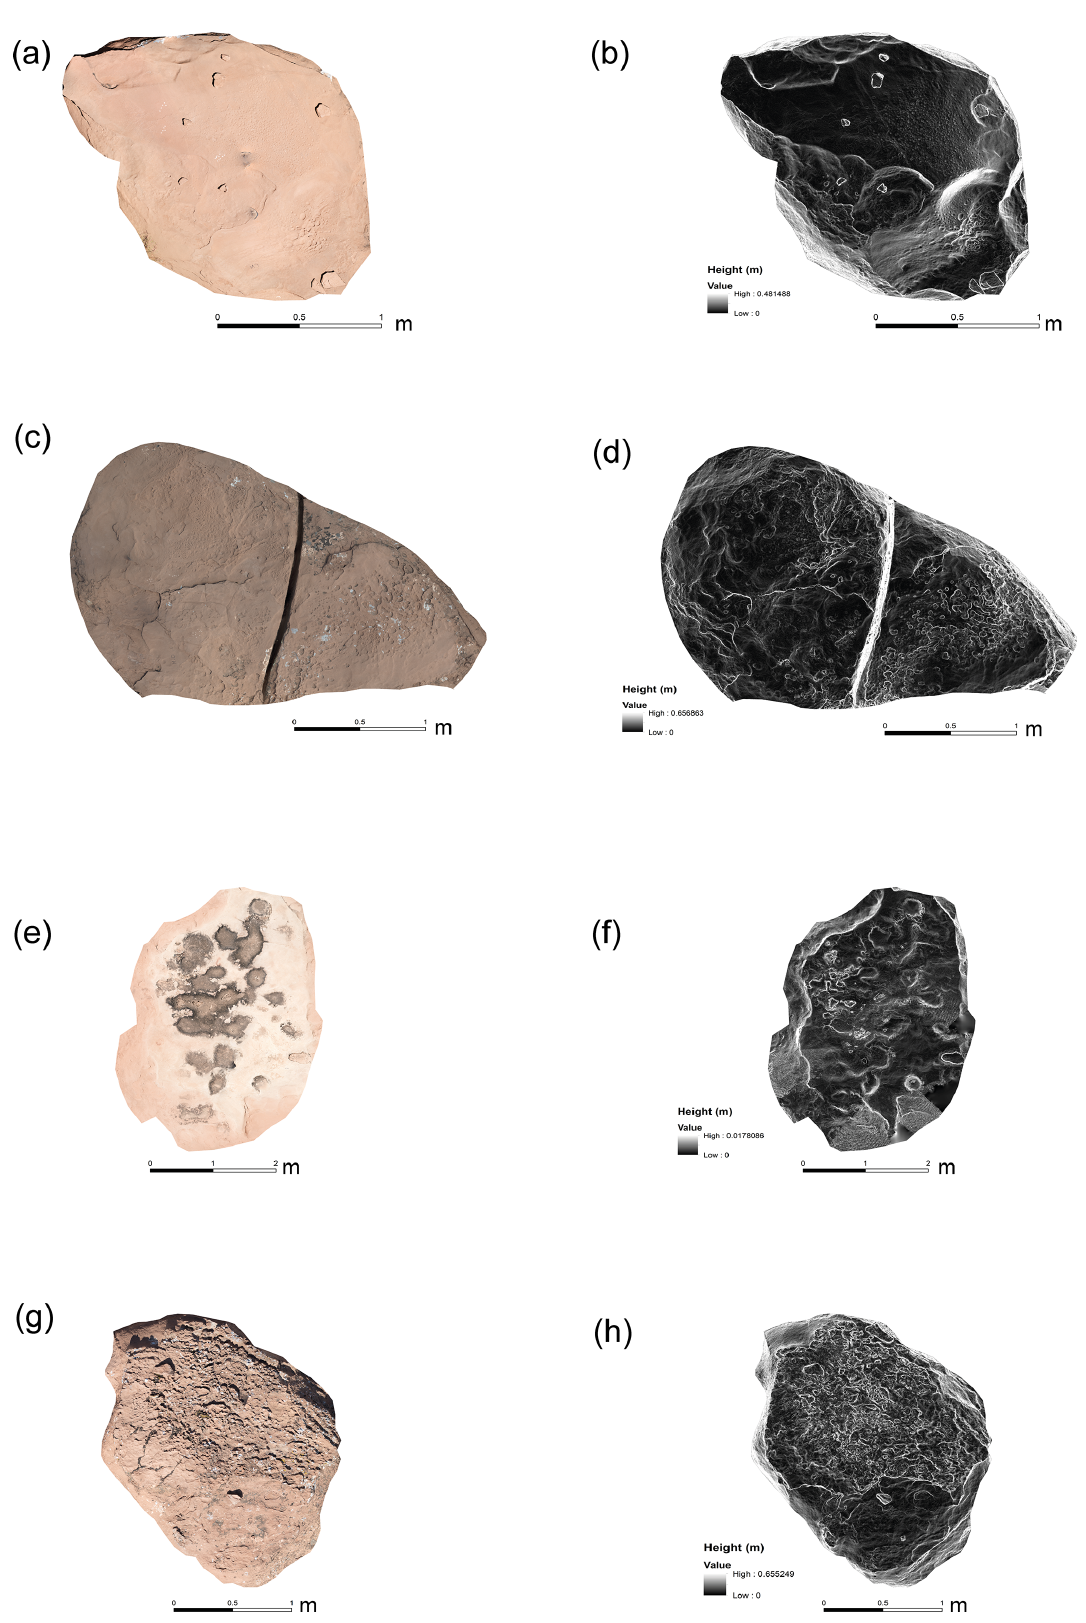
Figure 10. Orthophotos and DEMs of Moenkopi outcrops. (a, b) Bedrock S2-M7. (c, d) Bedrock S2-M20. (e, f) Bedrock S3-M33. (g, h) Boulder